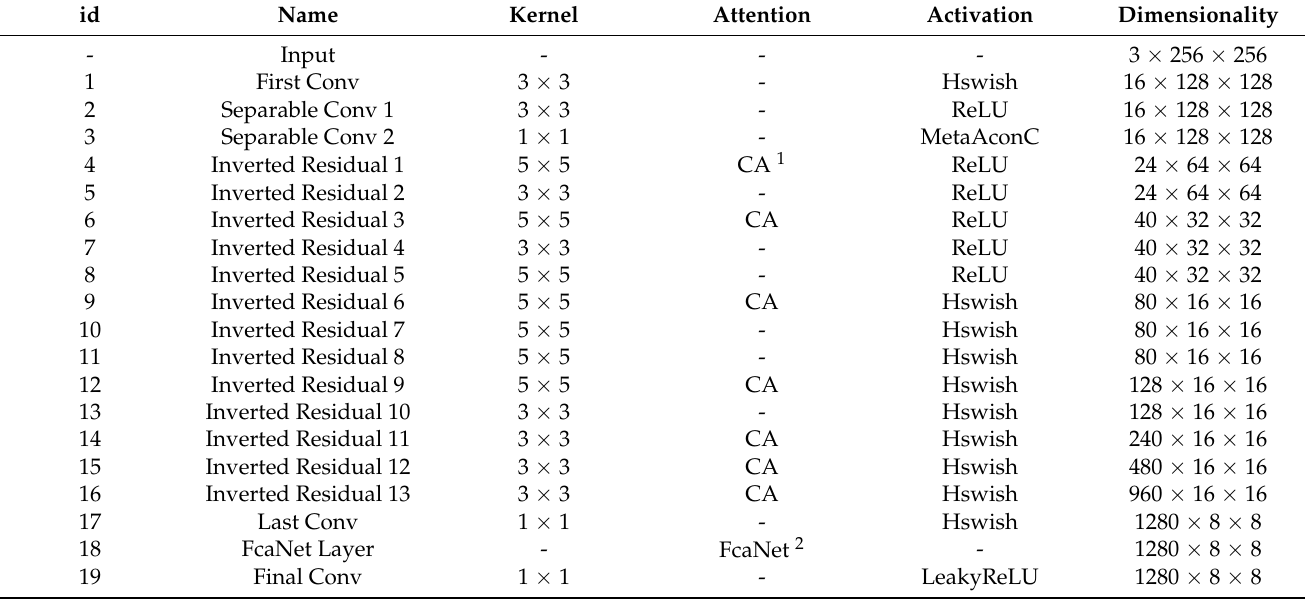
Table 1. The structure of feature extraction network in